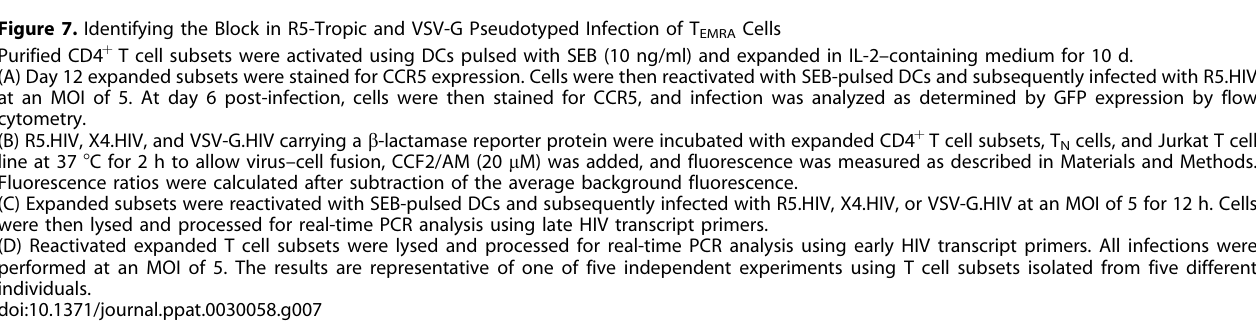
Figure 7. Identifying the Block in R5-Tropic and VSV-G Pseudotyped Infection of T EMRA Cells Purified CD4 þ T cell subsets were activated using DCs pulsed with SEB (10 ng/ml) and expanded in IL-2–containing medium for 10 d. (A) Day 12 expanded subsets were stained for CCR5 expression. Cells were then reactivated with SEB-pulsed DCs and subsequently infected with R5.HIV at an MOI of 5. At day 6 post-infection, cells were then stained for CCR5, and infection was analyzed as determined by GFP expression by flow cytometry. (B) R5.HIV, X4.HIV, and VSV-G.HIV carrying a b -lactamase reporter protein were incubated with expanded CD4 þ T cell subsets, T N cells, and Jurkat T cell line at 37 8 C for 2 h to allow virus–cell fusion, CCF2/AM (20 l M) was added, and fluorescence was measured as described in Materials and Methods. Fluorescence ratios were calculated after subtraction of the average background fluorescence. (C) Expanded subsets were reactivated with SEB-pulsed DCs and subsequently infected with R5.HIV, X4.HIV, or VSV-G.HIV at an MOI of 5 for 12 h. Cells were then lysed and processed for real-time PCR analysis using late HIV transcript primers. (D) Reactivated expanded T cell subsets were lysed and processed for real-time PCR analysis using early HIV transcript primers. All infections were performed at an MOI of 5. The results are representative of one of five independent experiments using T cell subsets isolated from five different individuals.